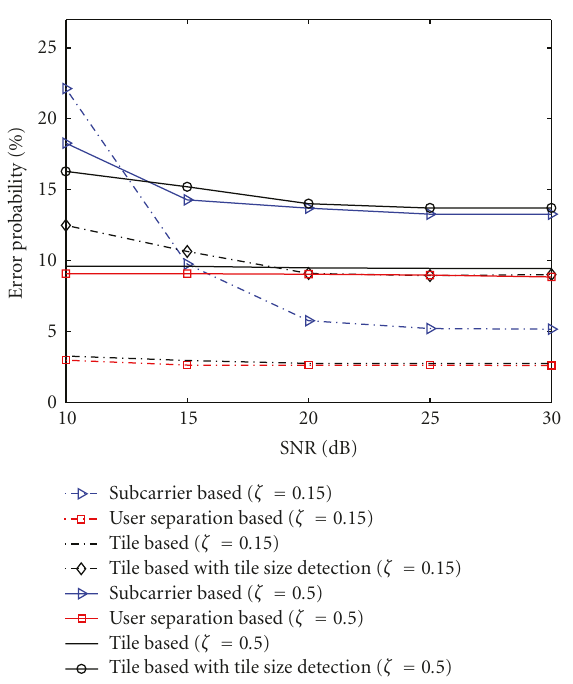
Figure 10: Error probability in detecting the spectrum opportuni- ties using four di ff erent methods for a resource block size of 6 ×